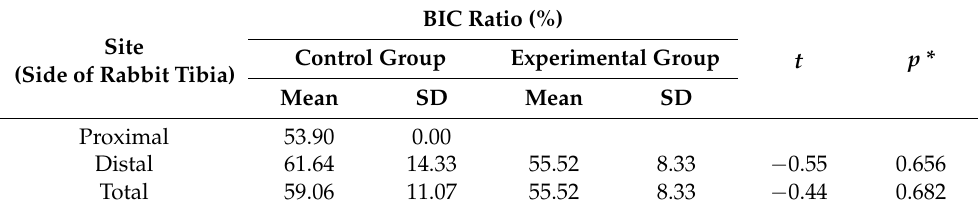
Table 5. Comparison of the bone-to-implant contact (BIC) ratio (%) between the control and experi- mental